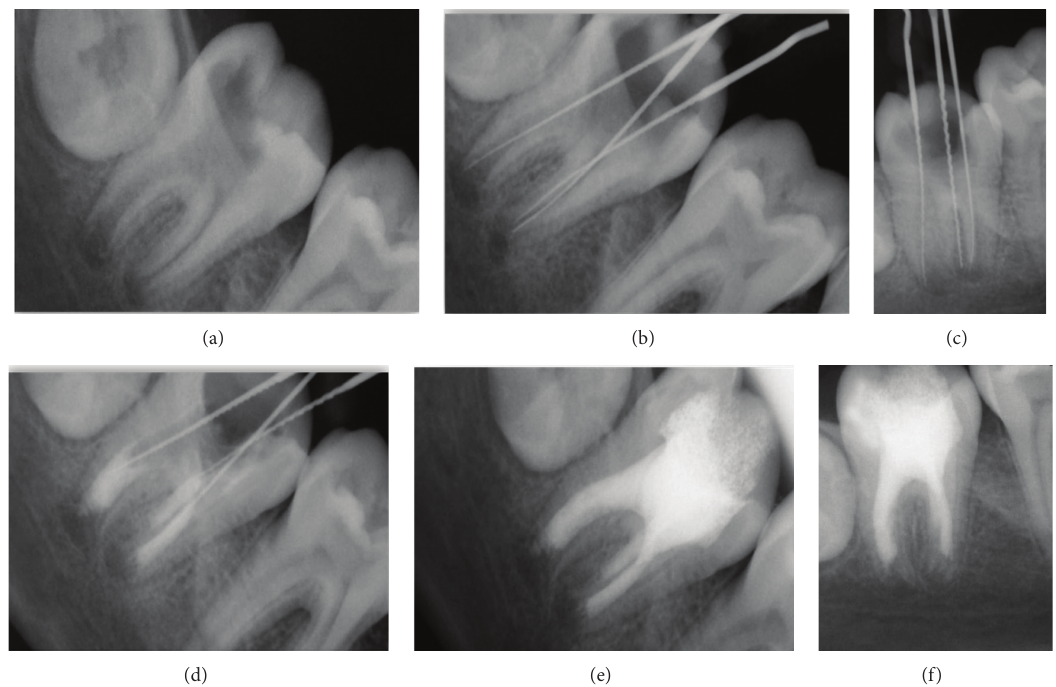
Figure 1: (a) Preoperative. (b) and (c) Working length determination. (d) MTA apical plug of 4-5mm thickness. (e) Final obturation. (f) After 8-month reassessment, continuous lamina dura and consistent width of periodontal ligament space suggest healing of the periapical